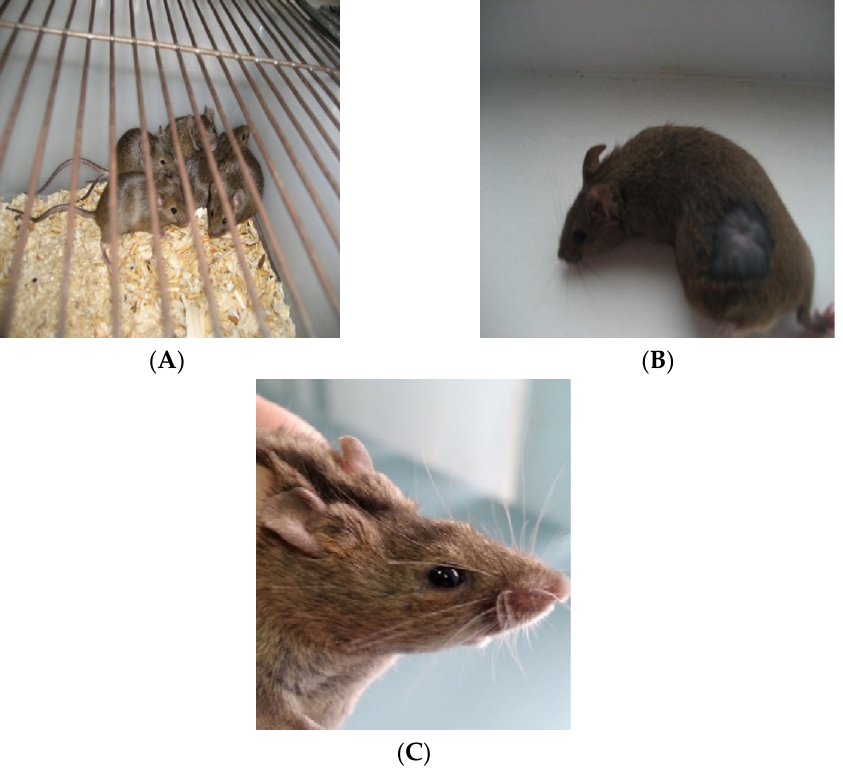
Figure 3. Mouse Hybrid F1 Line (CBA × C57BL/6) during the study: ( A ) reactions of the digestive system; ( B ) skin reactions; ( C ) effects on the mucous membrane of the eye. Table 3. Body weight of mice (g) with the introduction of the filtrate into the stomach (average values of 10 experimental individuals are